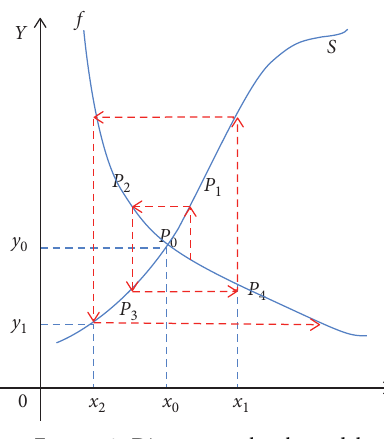
Figure 9: Divergent cobweb model.